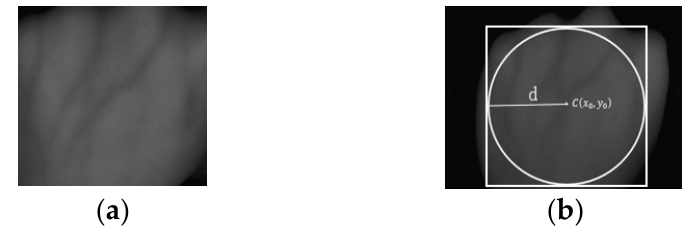
Figure 3. Captures the region of interest (ROI) area. ( a ) Maximum inscribed circle; ( b ) ROI area.